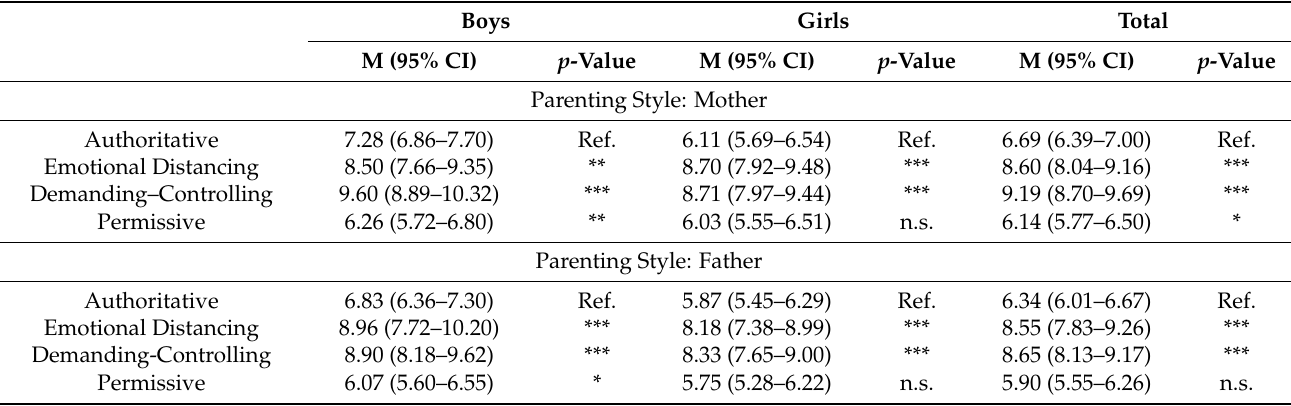
Table 4. Strengths and Difficulties Questionnaire total difficulties scores for girls and boys stratified by mother’s and father’s parenting style (weighted means, 95% confidence intervals, p -values).